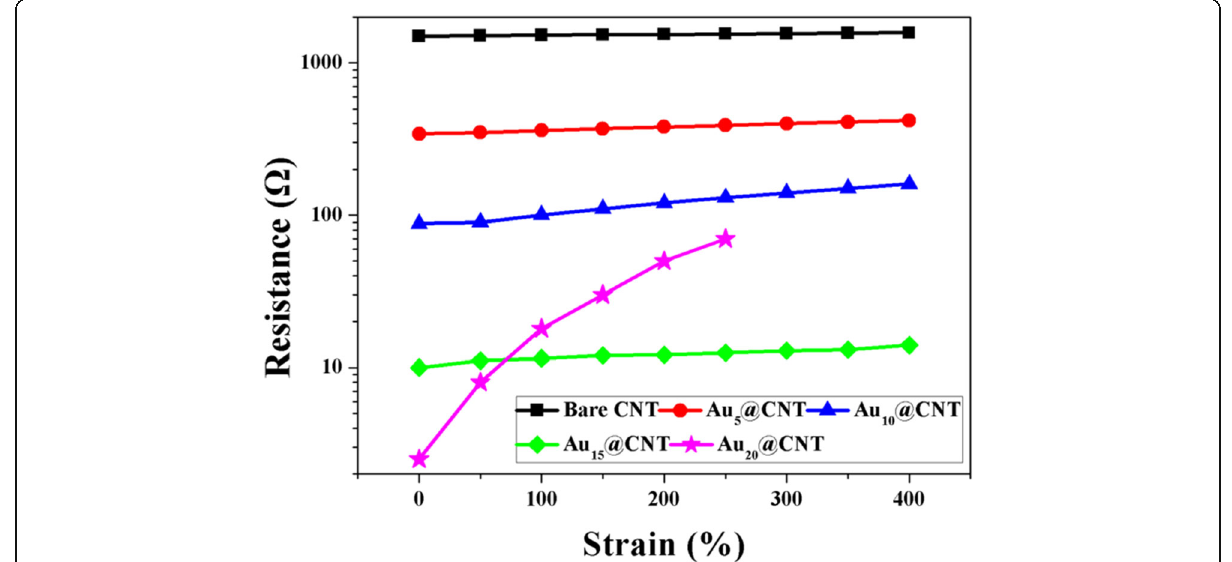
Fig. 3 The strain dependence of electrical resistance for CNT@fiber and Au x